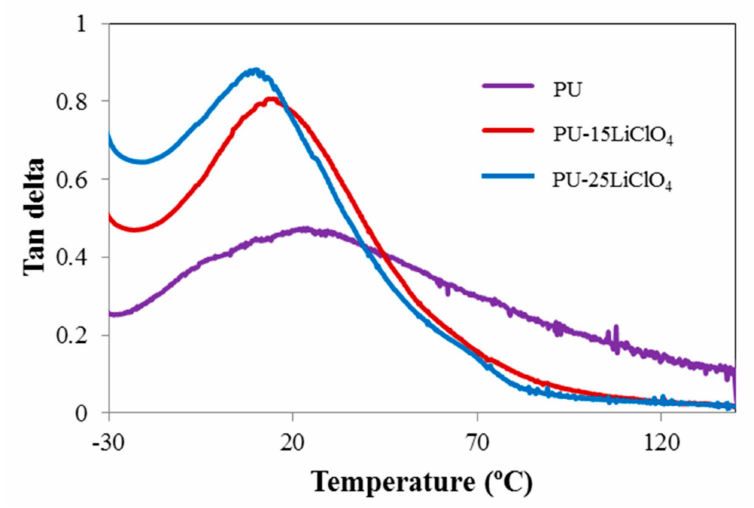
Figure 18. Tan delta of PU, PU-15LiClO 4 , and PU-25LiClO 4 as a function of temperature.